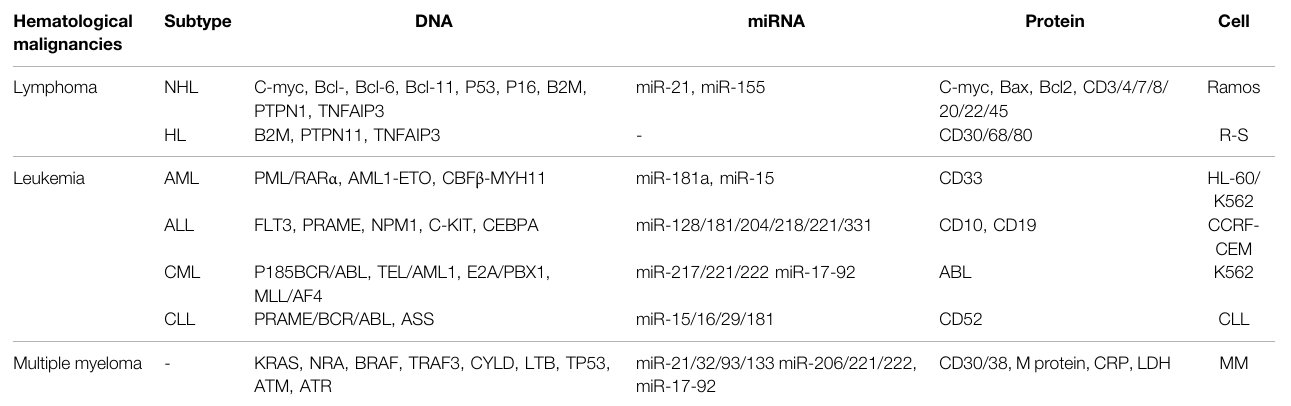
TABLE 1 | Currently used hematologic tumor-related